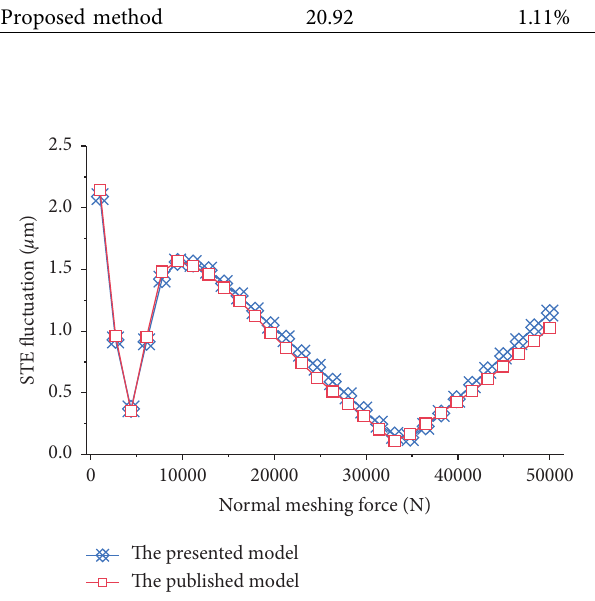
Figure 7: STE fluctuations of a modified helical gear pair under different load